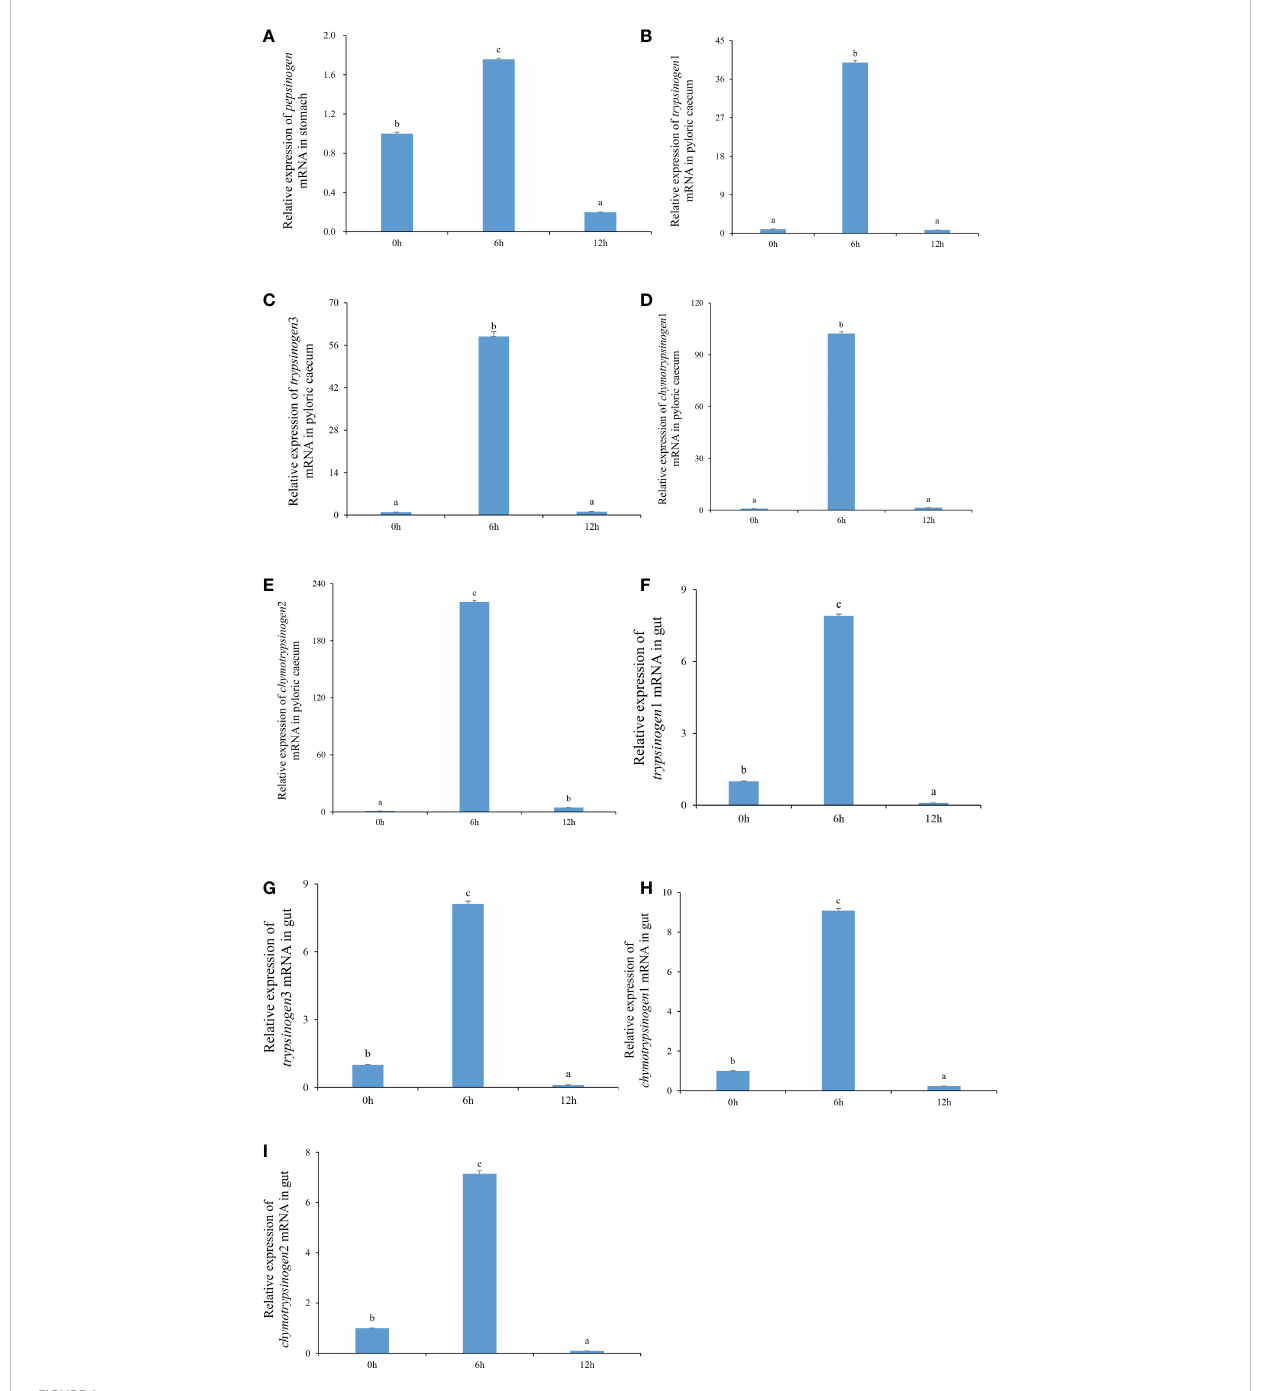
FIGURE 1 The expression levels of pepsinogen, trypsinogen1, trypsinogen3, chymotrypsinogen1 , and chymotrypsinogen2 in the gastrointestinal tissues of pond-cultured Japanese fl ounder. (A) pepsinogen in the stomach; (B) trypsinogen1 in the pyloric caecum; (C) trypsinogen3 in the pyloric caecum; (D) chymotrypsinogen1 in the pyloric caecum; (E) chymotrypsinogen2 in the pyloric caecum; (F) trypsinogen1 in the gut; (G) trypsinogen3 in the gut; (H) chymotrypsinogen1 in the gut; (I) chymotrypsinogen2 in the gut. Different lowercase letters represented that values were signi fi cantly different among different sampling times for each gene (n = 3, P <